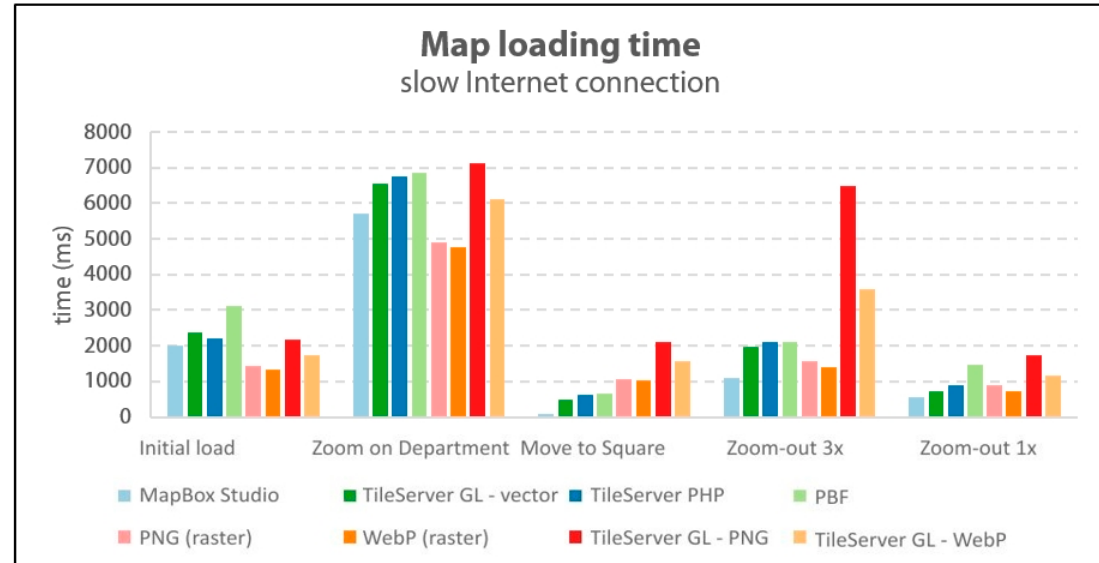
Figure 4. Results of map loading time (slow Internet connection).